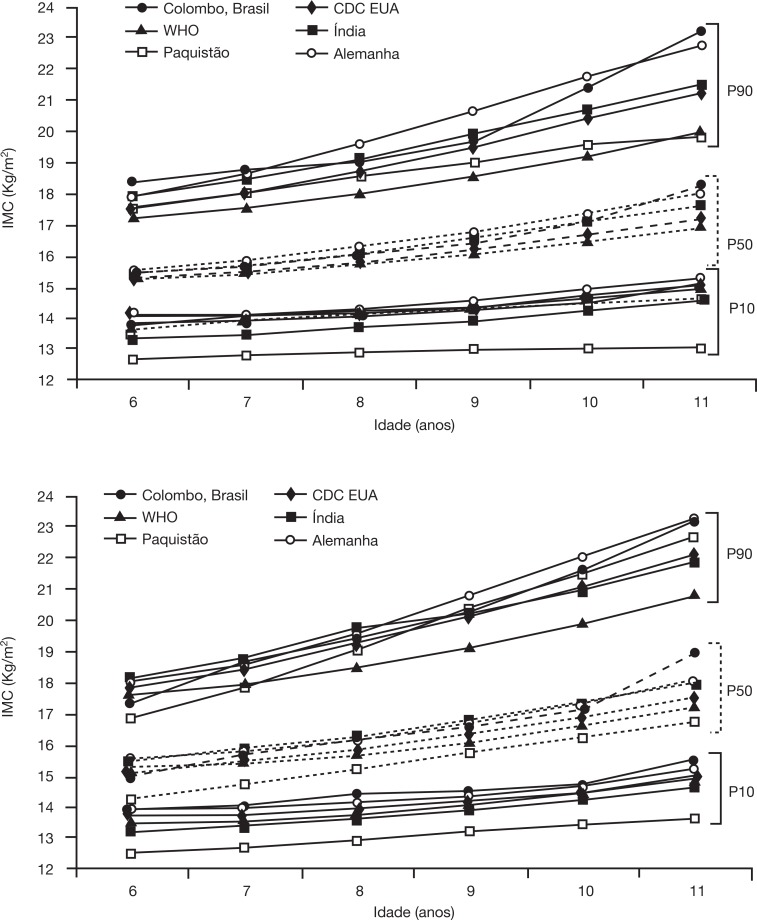
Comparação dos valores de percentis 10, 50, e 90 para índice de massa
corporal entre crianças de Colombo e crianças de outros países